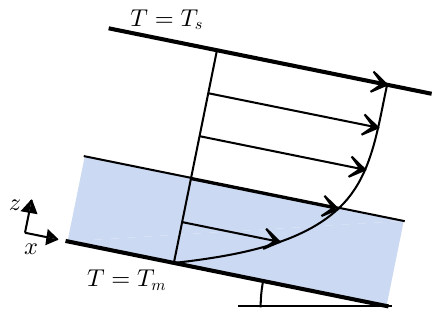
Figure 1. Parallel-sided slab setup. Arrows indicate the bed-parallel velocity, and shading indicates the region of temperate ice (to be